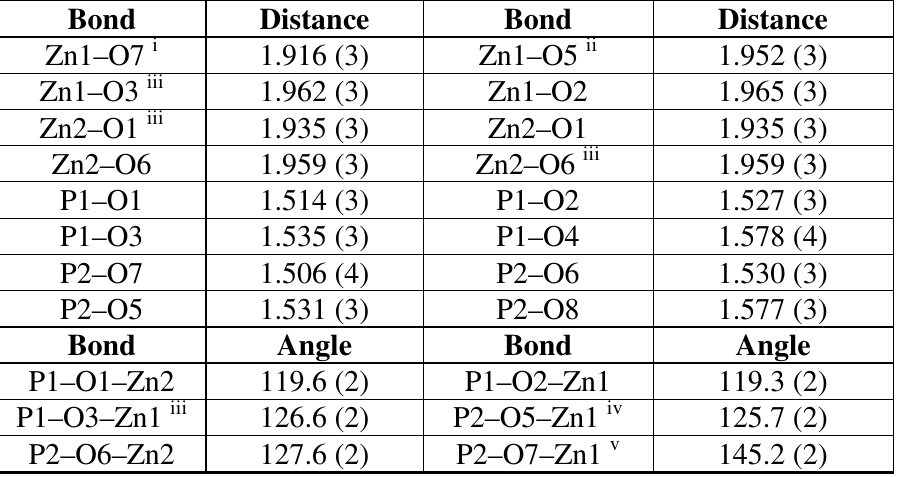
Table 1. Selected geometrical parameters (Å,°) for 1 .